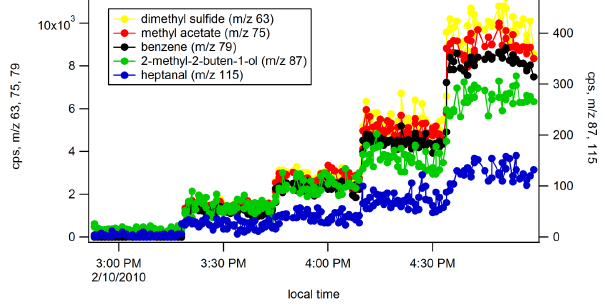
Figure 2: Example time series of PTR-MS signals (counts per second, cps) during dynamic injections of solution 1 into a 1.0 slpm UHP N 2 flow. Solution flow rates were injected at 0.0, 0.5, 1.0, 2.0, and 4.0 µL min -1 sequentially.